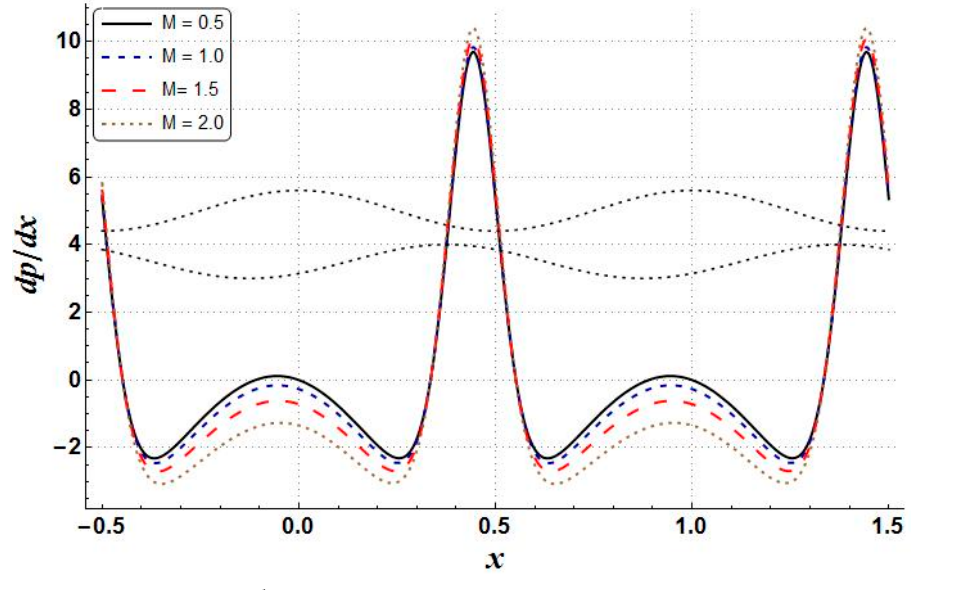
Figure 17. Influence on dp φ = 0.05, k = 2, a = 0.6, m = 1, d = 0.7, Br = 0.2, b = 0.5, ∈ = 2, η =